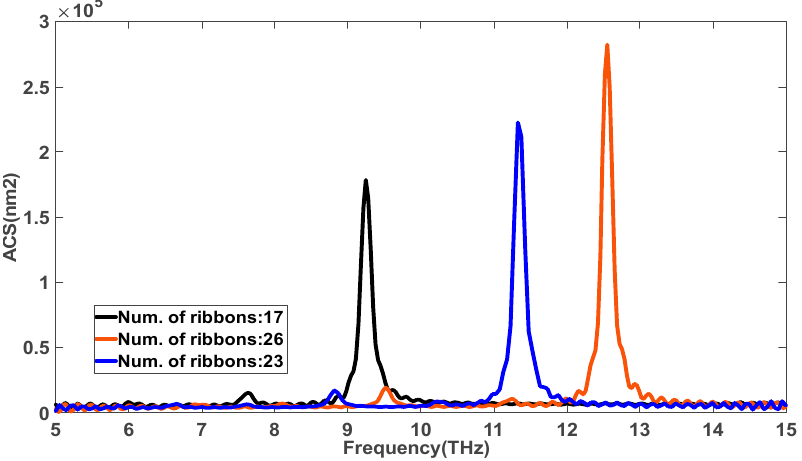
Figure 5. The influence of designed ribbons number of the graphene layer on ACS of perfect ab- sorber.